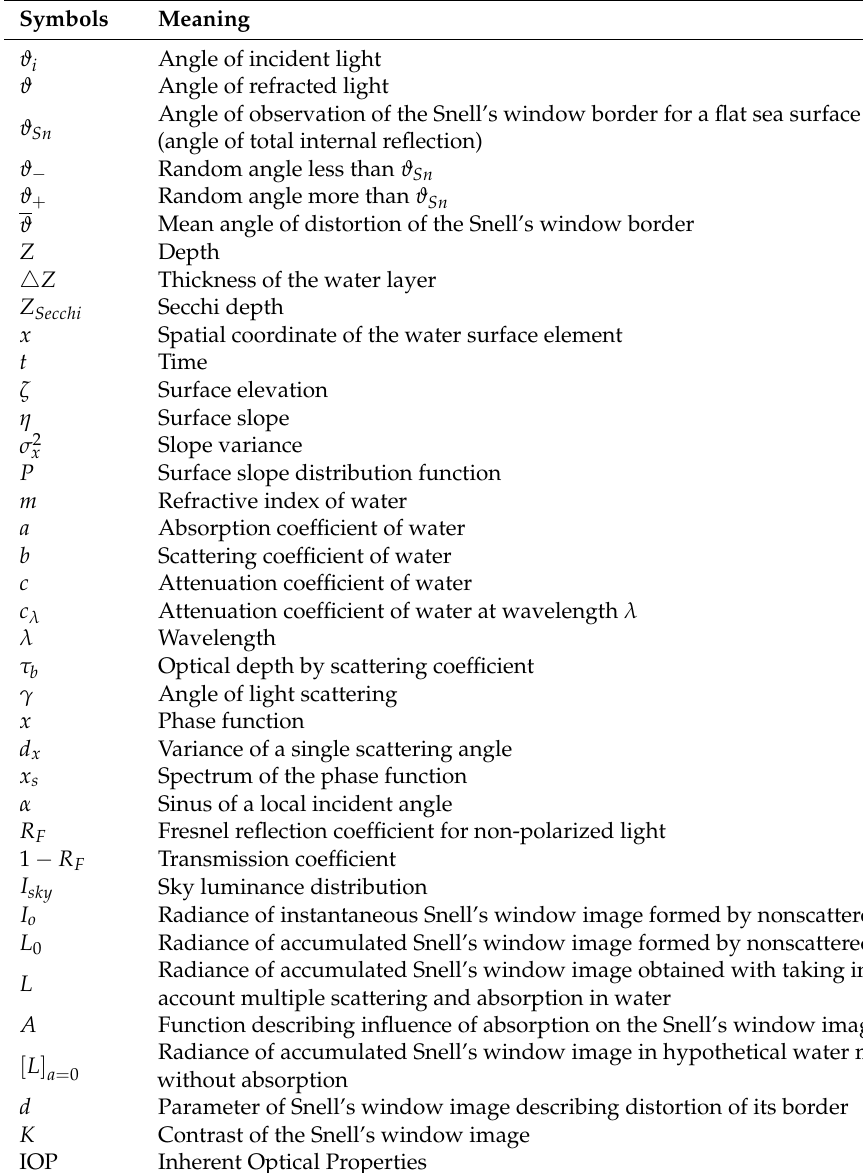
Table 1. Abbreviations and